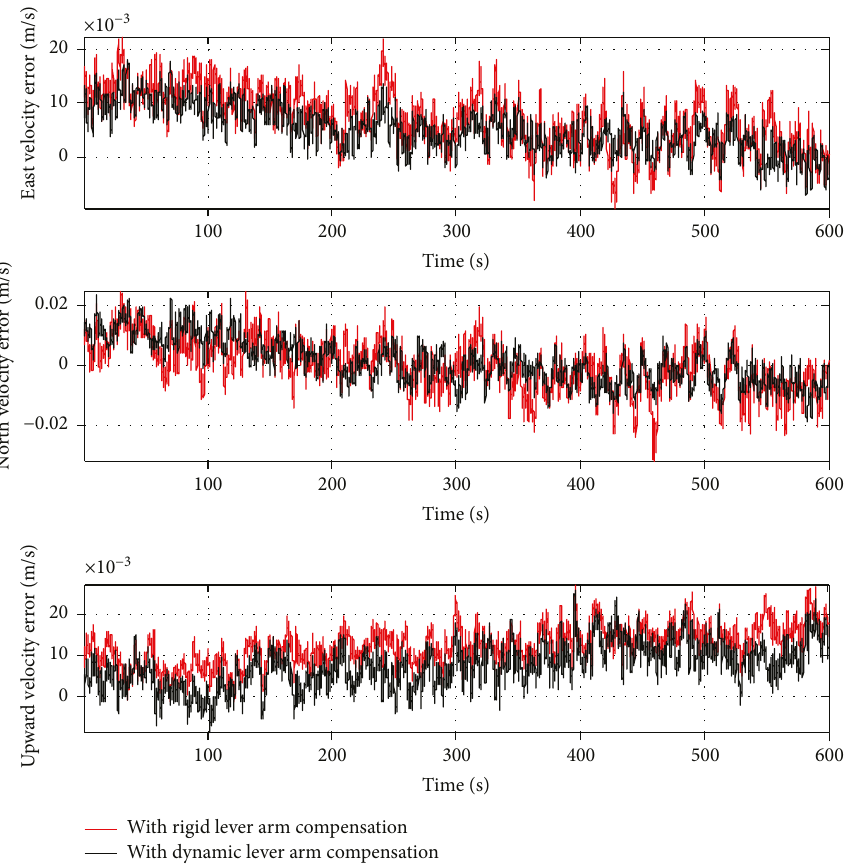
Figure 8: Velocity error comparison of the fi rst-level dynamic lever arm error compensation.